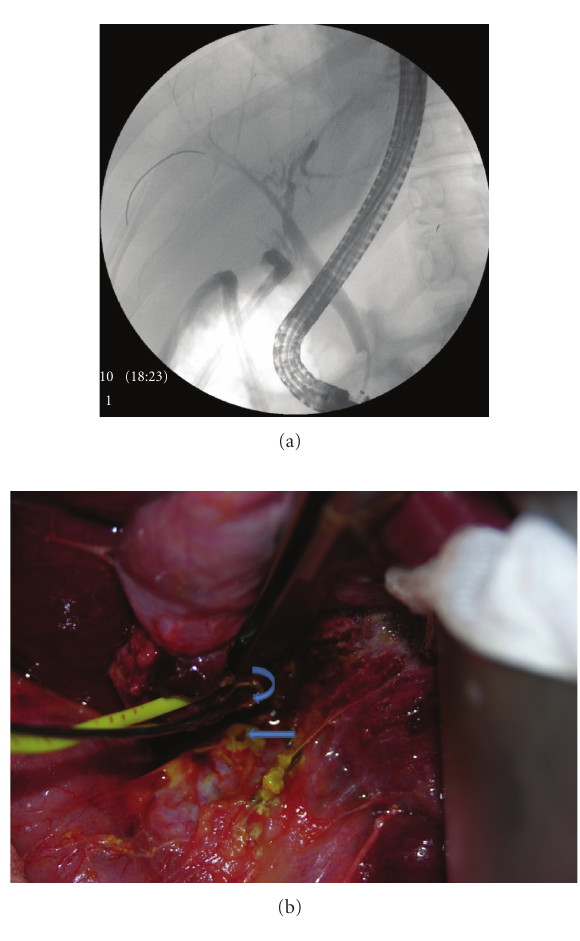
Figure 4: (a) Endoscopic retrograde cholangiopancreatography (ERCP) showing staples close to common bile duct with inadequate filling of intrahepatic ducts in right lobe of liver. (b) Operative photograph-probe in the torn aberrant duct ( curved arrow ) and ostium on the surface of cystic duct stump ( line arrow